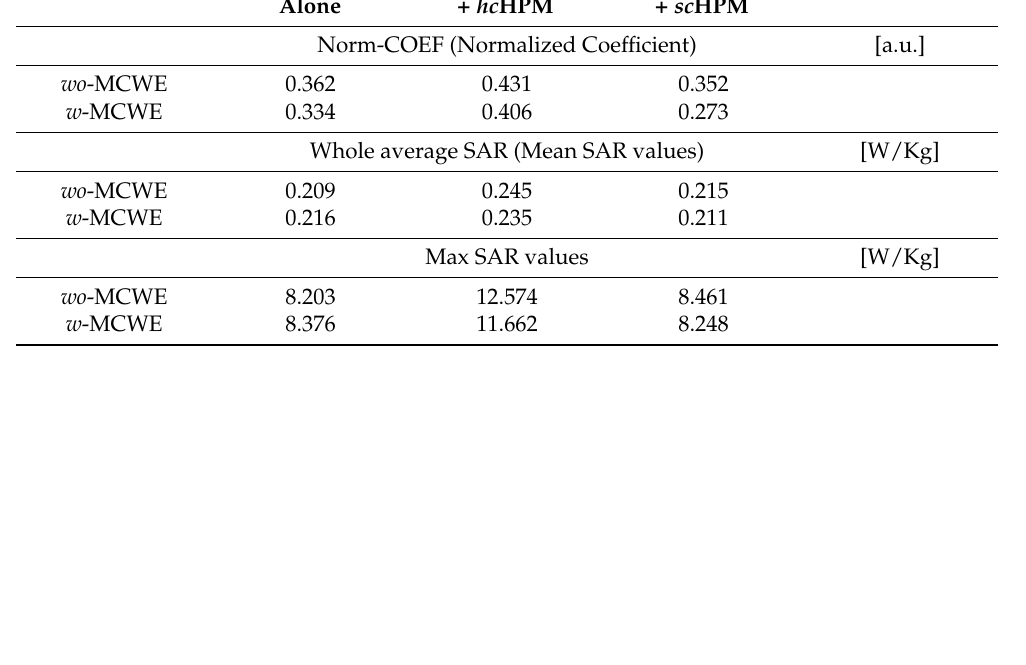
Figure 5d), BP-BC RF coil + hc HPM − w -MCWE (246.670 V/m; Figure 5e), and BP-BC RF coil